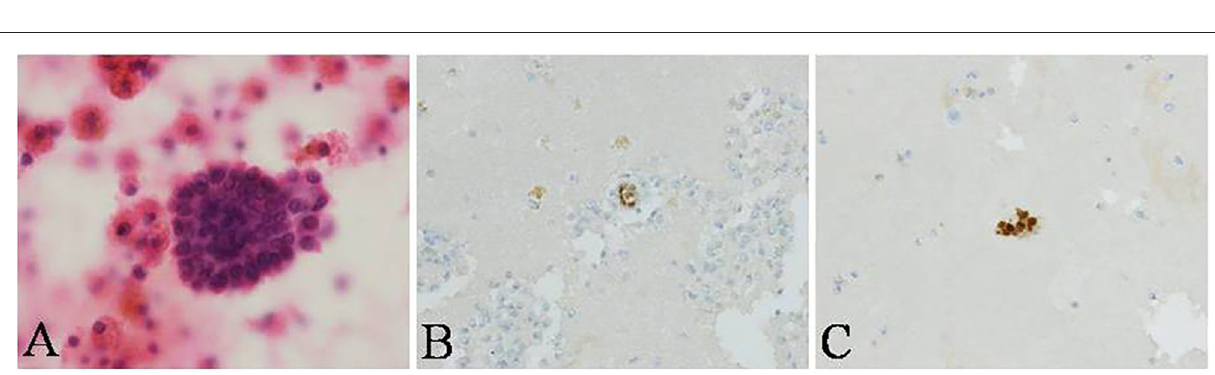
parenchymal endometriosis tended not to have pelvic